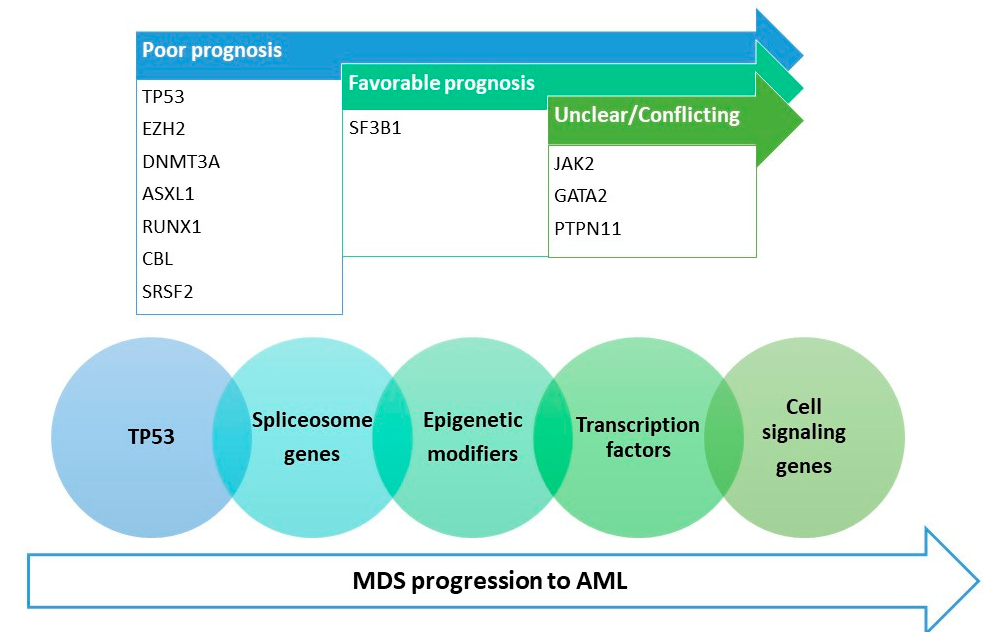
Figure 3. Gene mutations implicated in MDS progression to AML according to prognostics and the order of mutation acquisition (MDS—myelodysplastic syndrome, AML—acute myeloid leukemia, the order of acquisition of the mutations during MDS evolution to AML is represented with blue arrow).